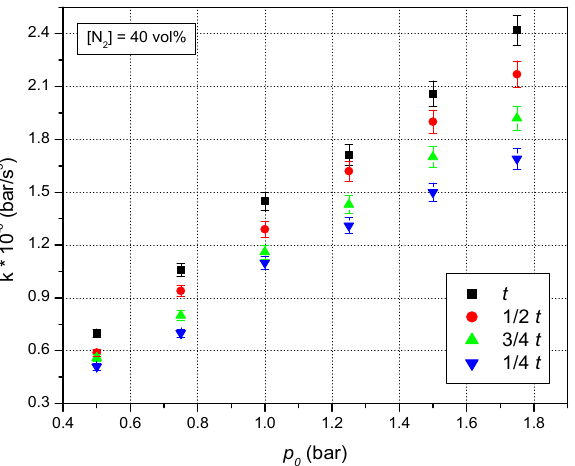
Figure 5. Variation of cubic law coefficients with initial pressure for stoichiometric CH 4 -N 2 O mixture diluted with 40% N 2 , at ambient initial temperature.